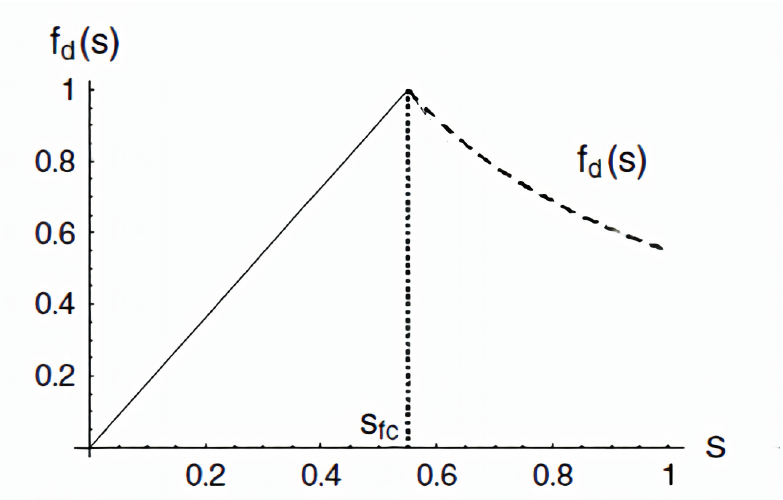
Figure 4. Variation of soil moisture factor with relative soil moisture